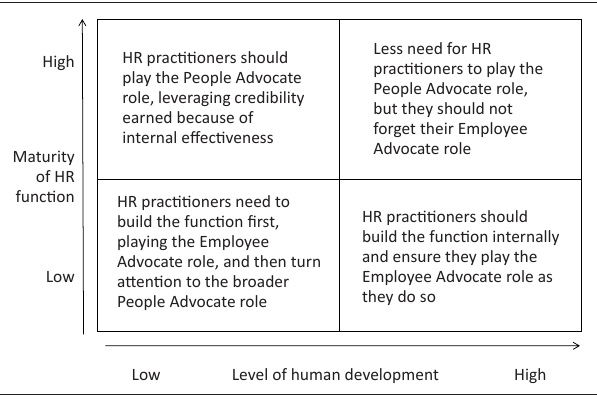
FIGURE 5: Relative importance of the People Advocate